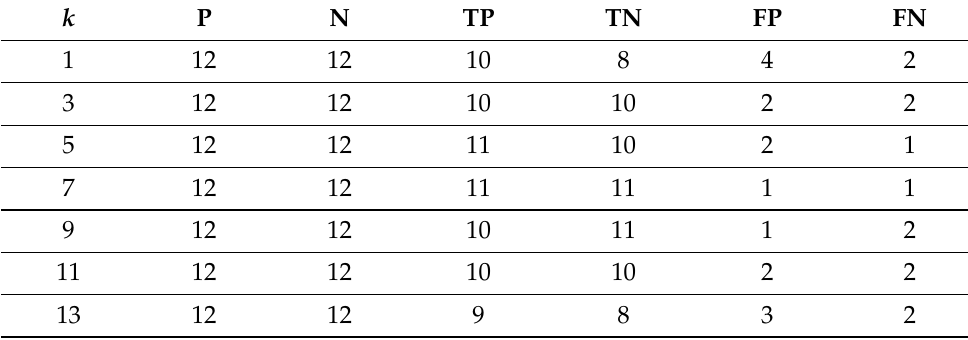
Table 2. Classification results for different values of parameter k .